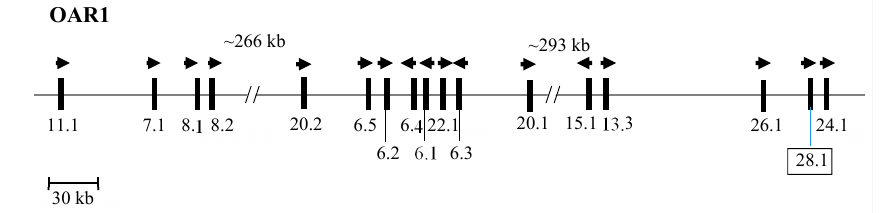
Figure 2. The KAP genes identified to date on sheep chromosome 1. The newly identified ovine KRTAP28-1 is shown in a box. Vertical bars signify the location of the KRTAPs and the arrowheads specify the direction of transcription. The numbers below the bars are the names of the KAP genes (i.e., 11.1 is KRTAP11-1 ). The nucleotide distances are inexact and refer to NC_019458.2.